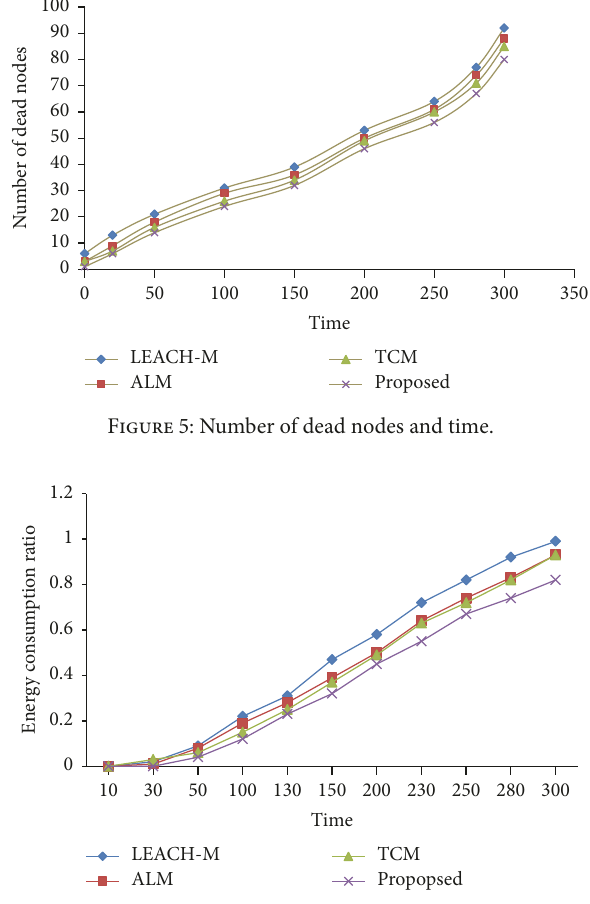
Figure 6: Average energy consumption ratio and